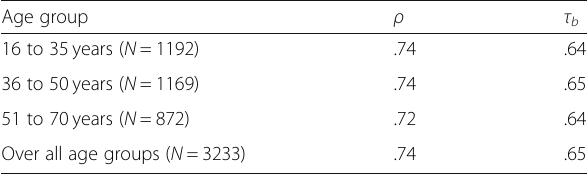
Table 4 Temporal consistency of “ The number of books in the home when respondent was 16 years old ” Age group ρ τ b